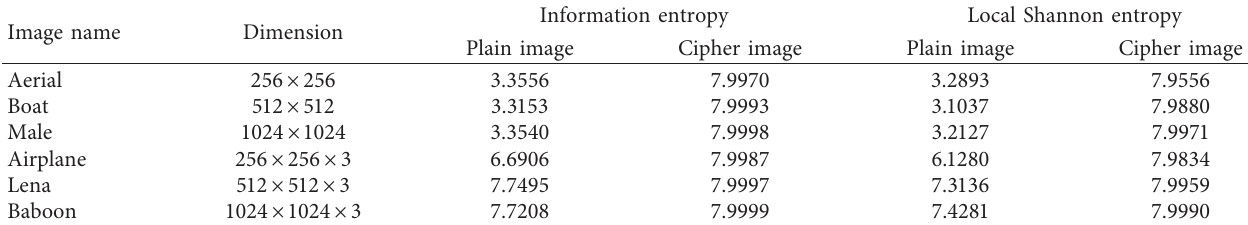
Table 6: Results of information entropy and local Shannon entropy.